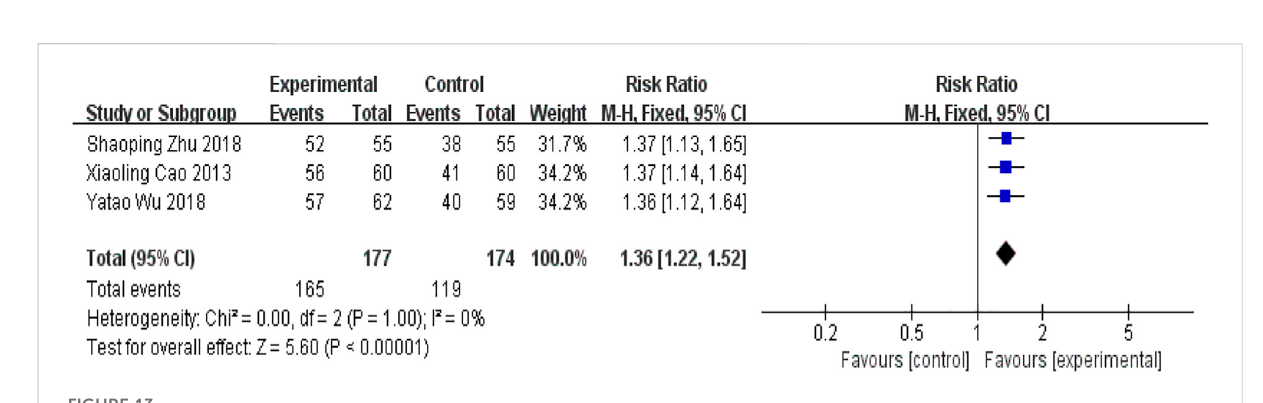
FIGURE 13 Forest plot for plaque area ef fi cacy.